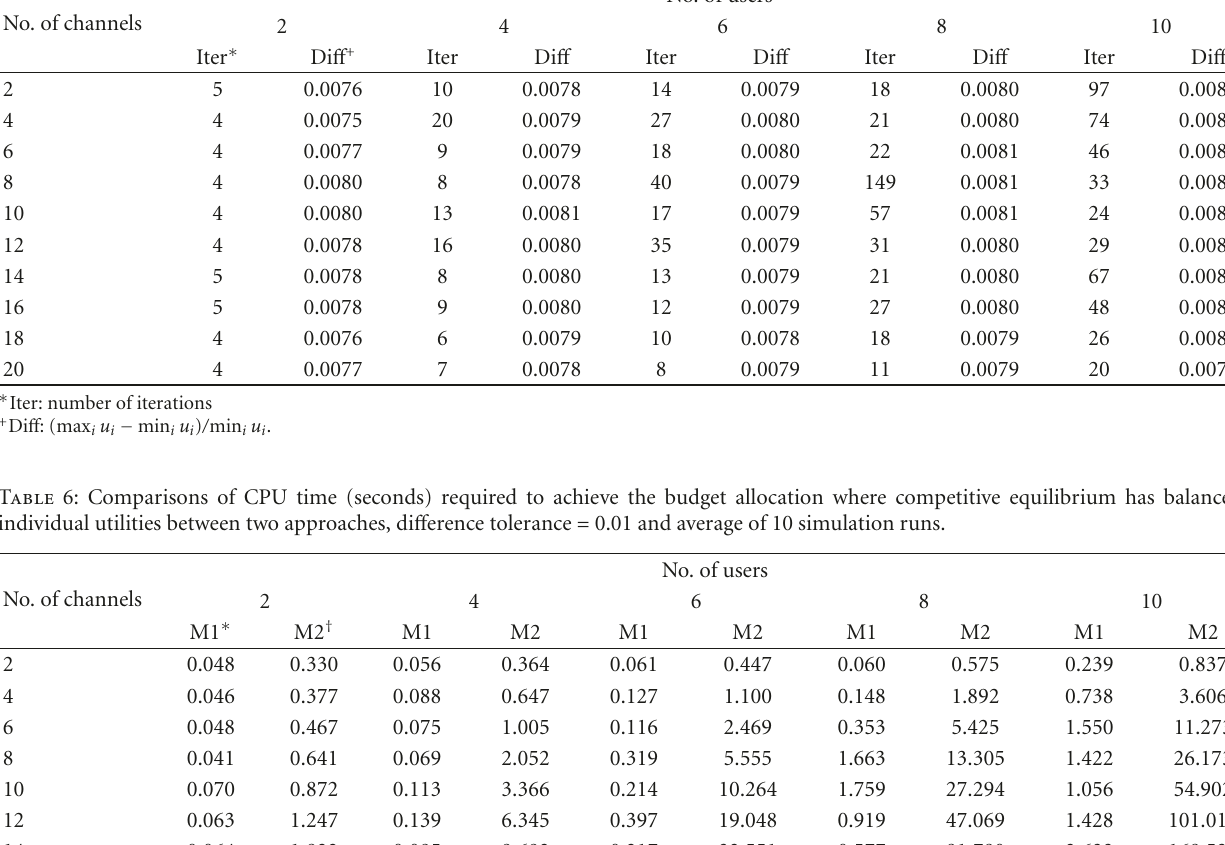
Table 5: Number of iterations required to achieve the budget allocation where the competitive equilibrium has balanced individual utilities by the iterative algorithm, di ff erence tolerance = 0.01 and average of 10 simulation runs. No. of channels